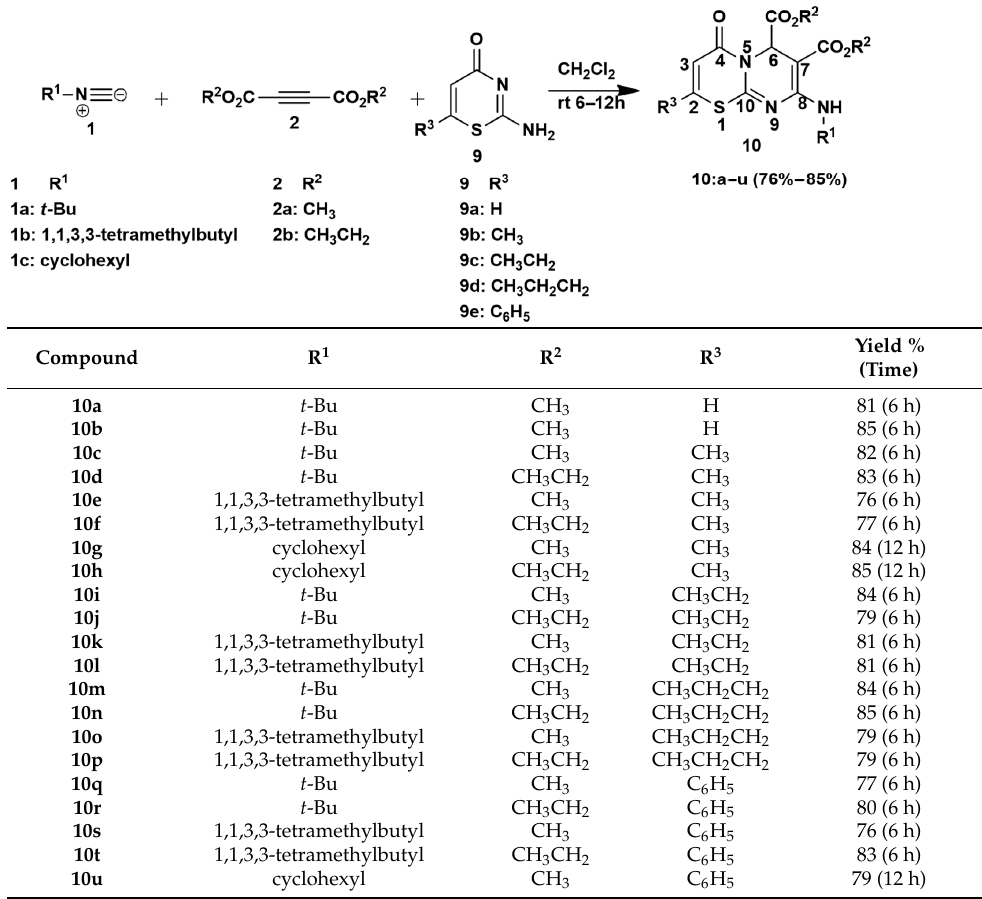
Figure 1. Six-membered rings 9a–e chosen for the three-component reaction. Table 1. Isolated yields of products 10a–u from the reaction of isocyanides 1 , dialkyl acetylenedicarboxylates 2 and thiazines 9 at room temperature.